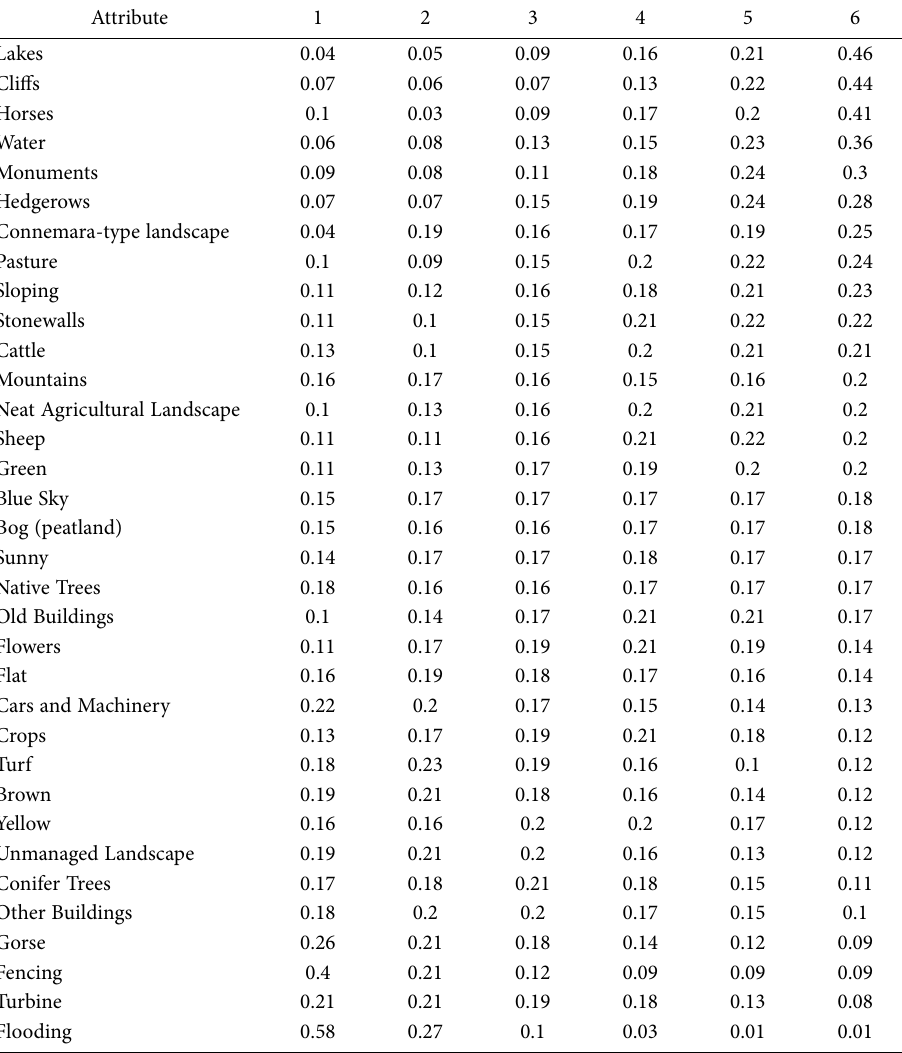
Table 4. Landscape Attribute Summary Statistics showing shares of preference rankings from not very highly (1) to very highly